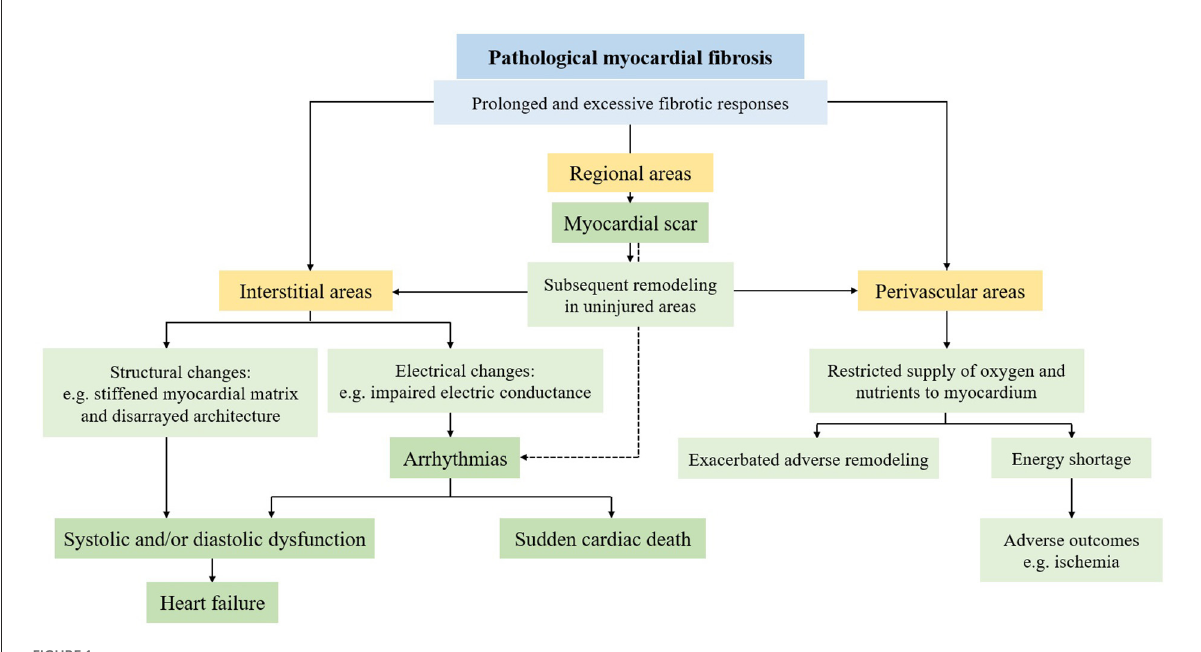
FIGURE1 Consequences of pathological myocardial